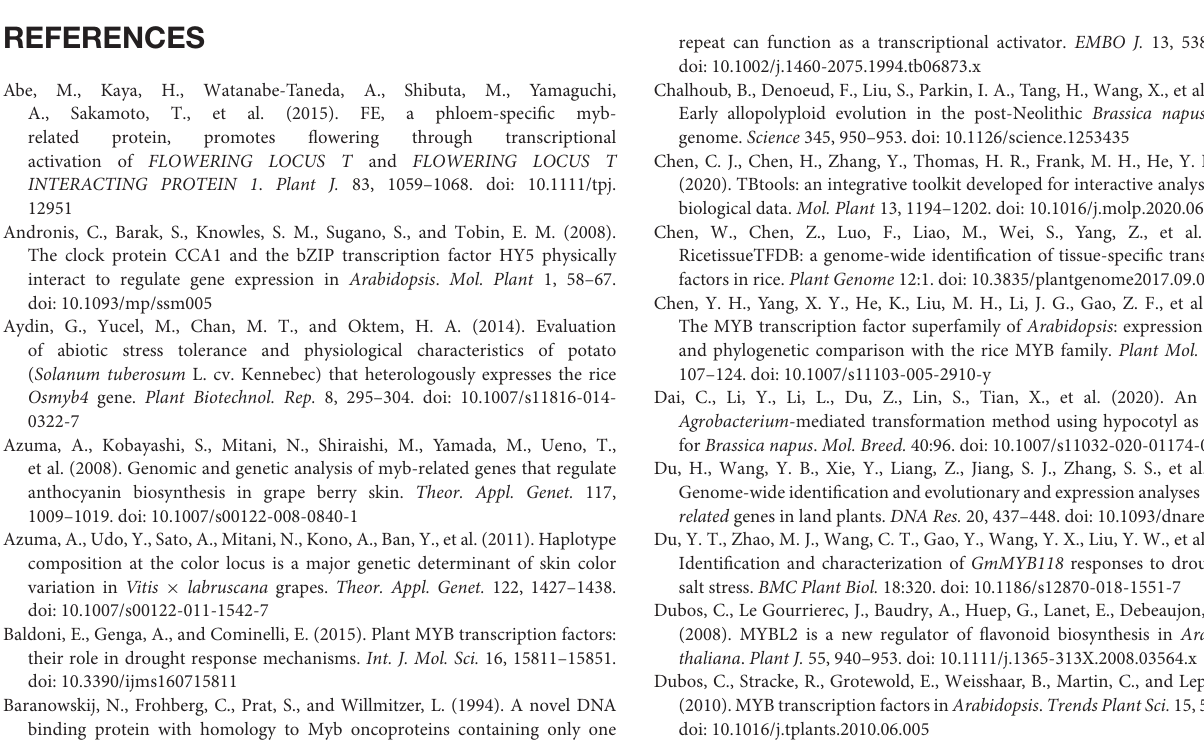
Supplementary Figure 1 | Distribution of MYB-related family genes on B. napus chromosomes. Several genes are not shown in this figure because they are located in unassembled scaffolds. Two hundred and thirty-one MYB-related genes were assigned to 19 chromosomes, and the names of the chromosomes are